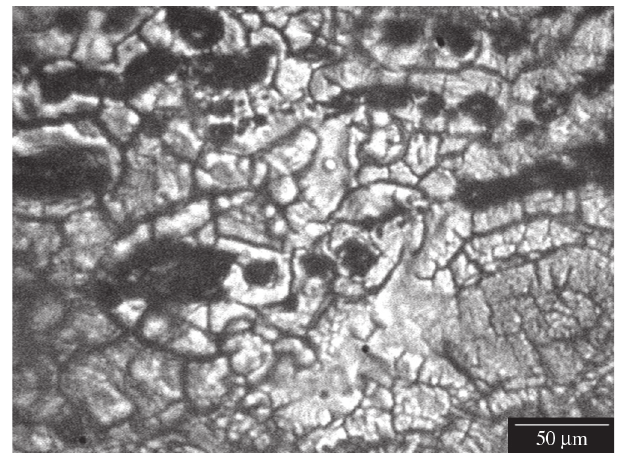
Figure 4. Microstructure in the DRX domain of 0.1 s -1 and at 400 °C. Figure 6. SEM image of debonded particle observed at 400 °C, 1.0 s -1 .